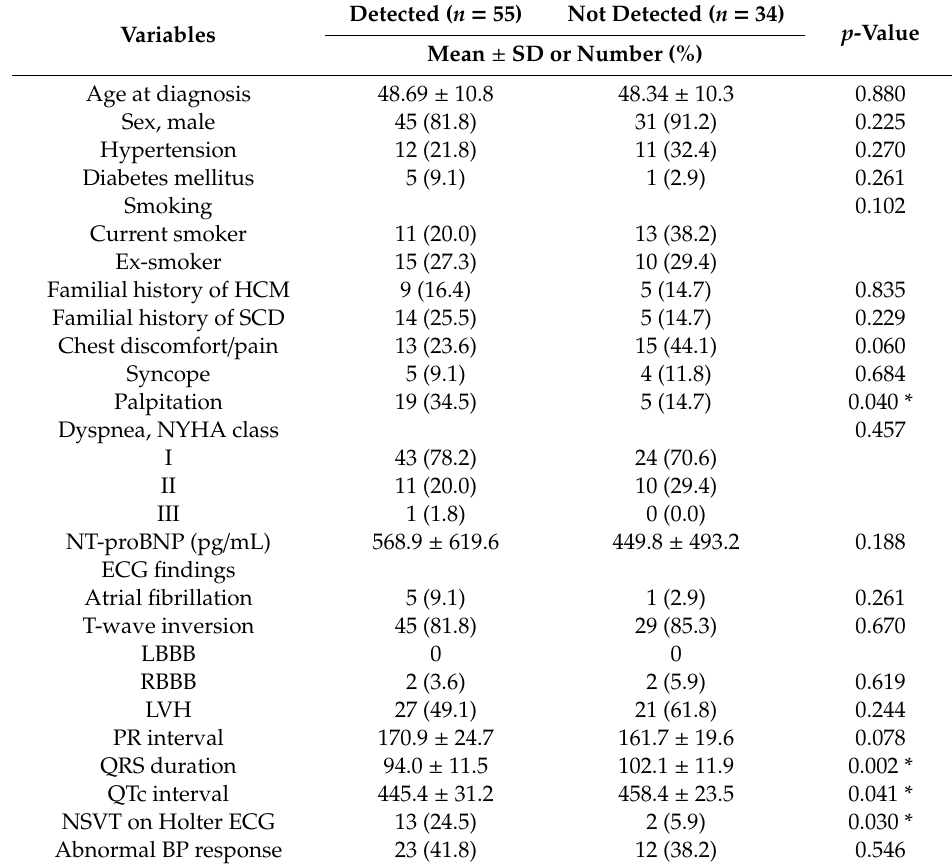
Table 2. Baseline demographic and clinical